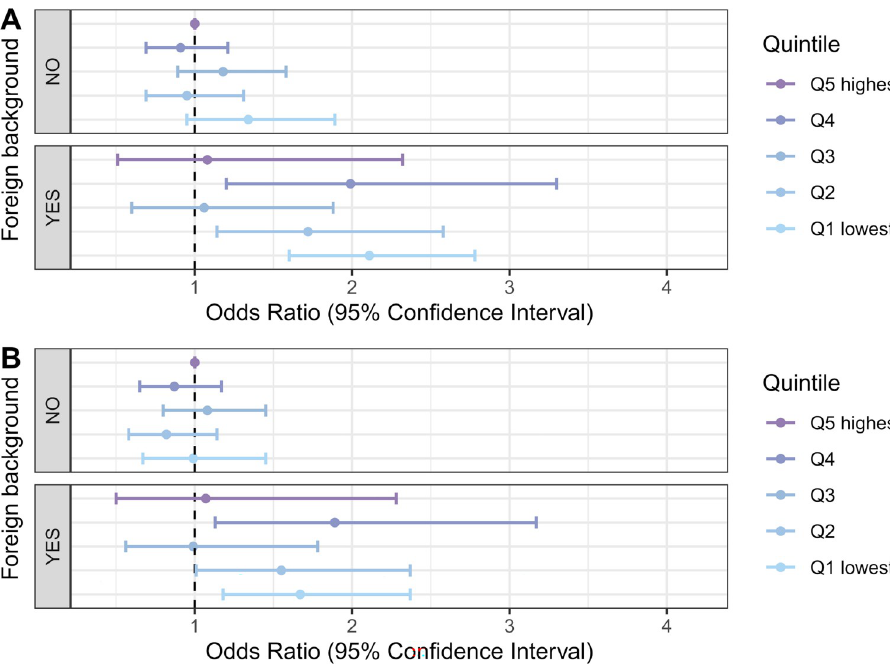
Fig 6. Odds ratios of severe COVID-19 illness among those infected by household income quintile and foreign background status. In under-65 households (A) adjusted for age and age squared, sex, regional characteristics, and comorbidities; (B) adjusted for age and age squared, sex, regional characteristics, comorbidities, household size, and household-level work and school exposures.